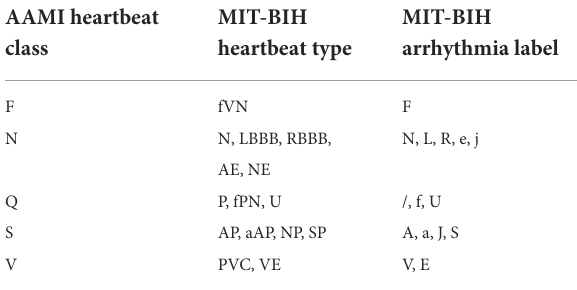
Experiment, the experimental results and discussions are shown. TABLE 1 Details of MIT-BIH arrhythmia